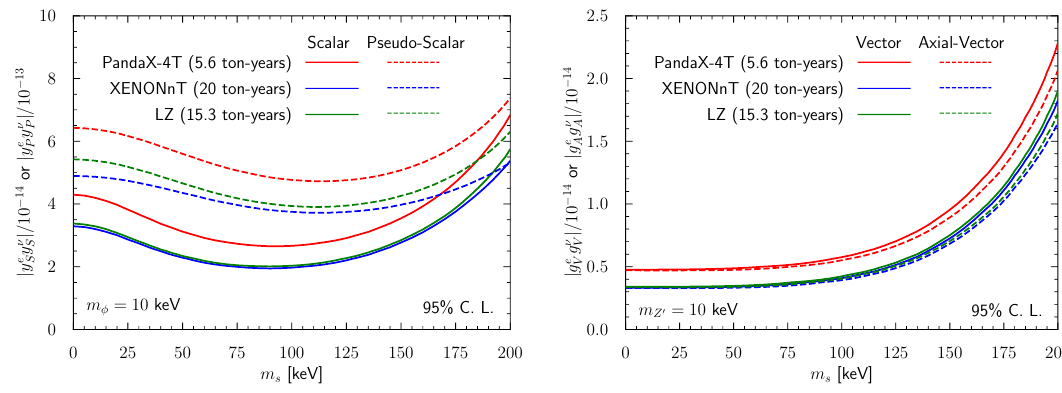
Figure 10 . The PandaX-4T (red), XENONnT (blue), and Lux Zeplin (green) projected 95% C.L. exclusion curves as a function of the sterile neutrino mass m s . The left panel is for the scalar (solid) and pseudo-scalar (dashed) mediators while the right panel is for the vector (solid) and axial-vector (dashed) interactions. In all cases, the mediator mass is fixed at m φ,Z 0 = 10